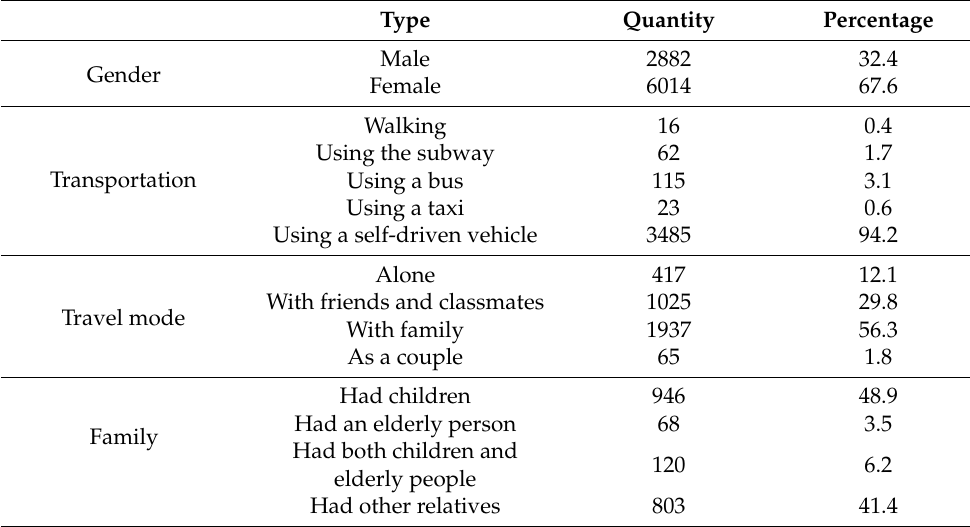
Table 5. Statistical analysis of the tourist